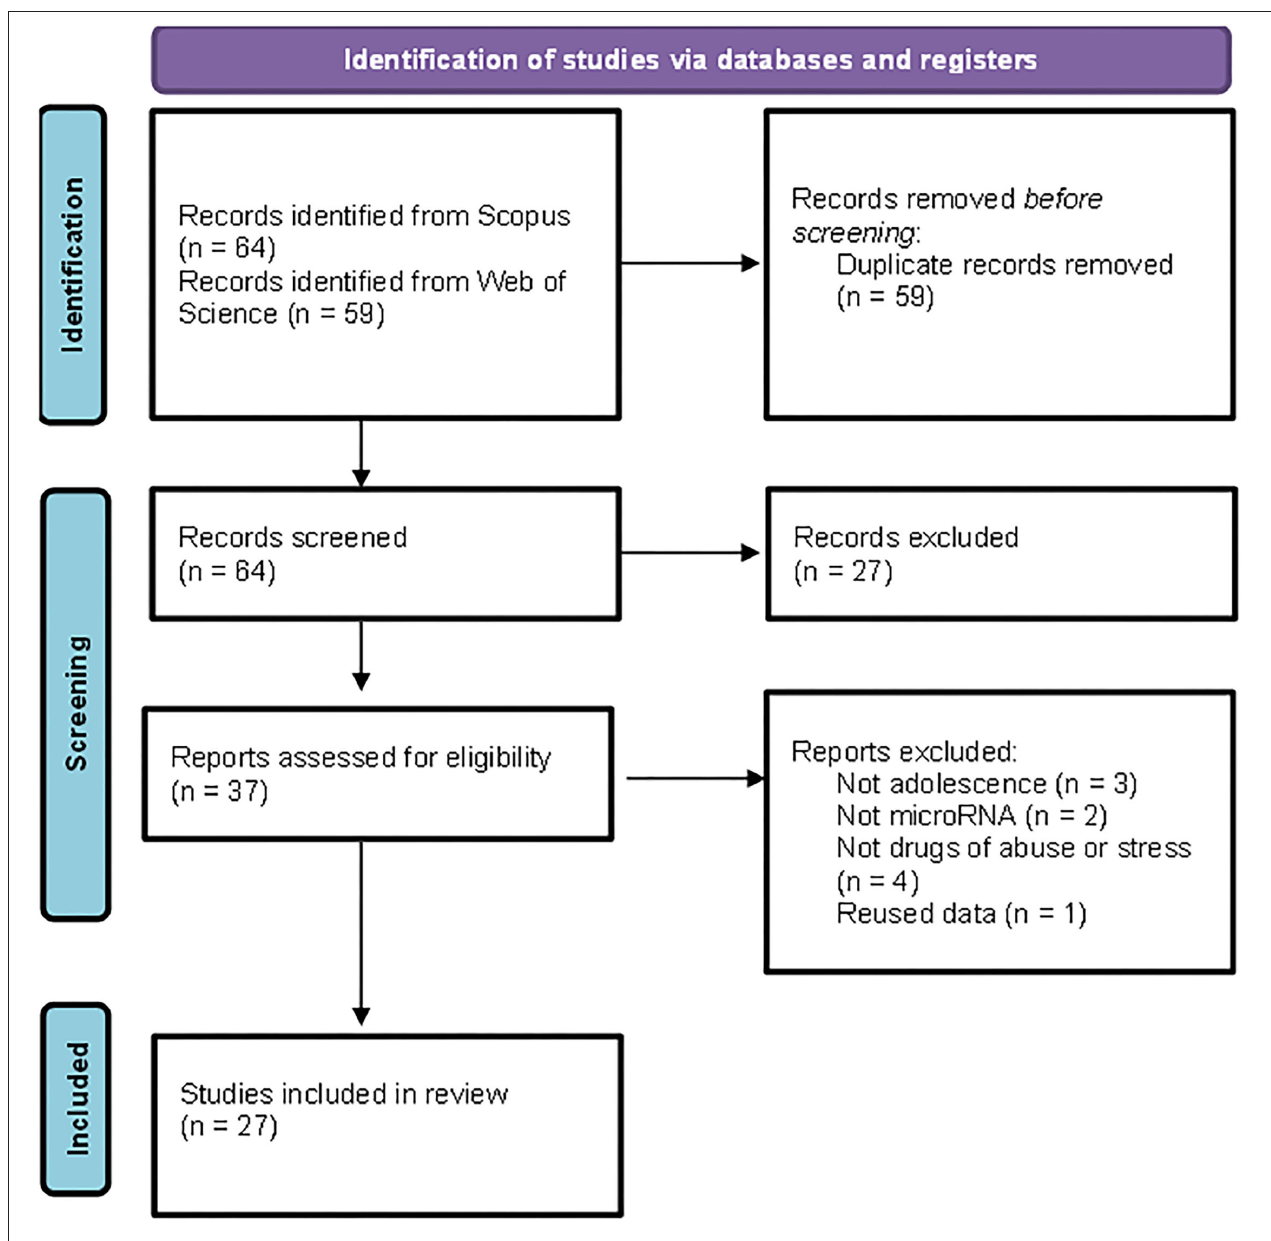
FIGURE 1 | Preferred Reporting Items for Systematic Reviews and Meta-Analyses (PRISMA) flowchart illustrating the search strategy applied to select the publications included in the review.